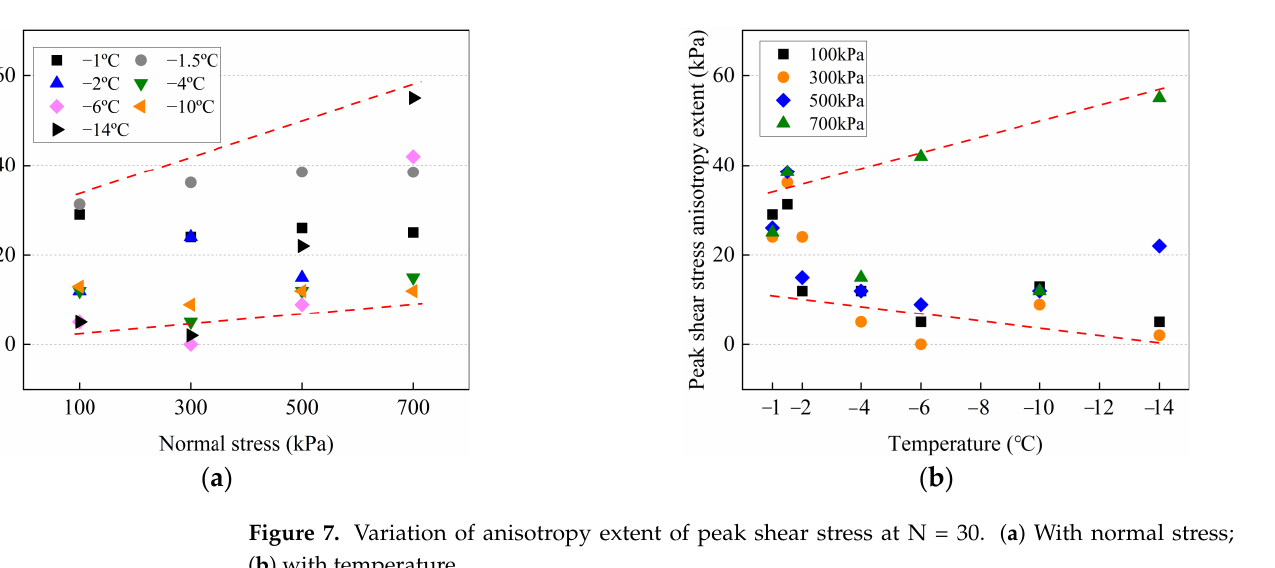
Figure 6. Variation of anisotropy extent of peak shear stress at N = 1. ( a ) With normal stress; ( b ) with temperature.